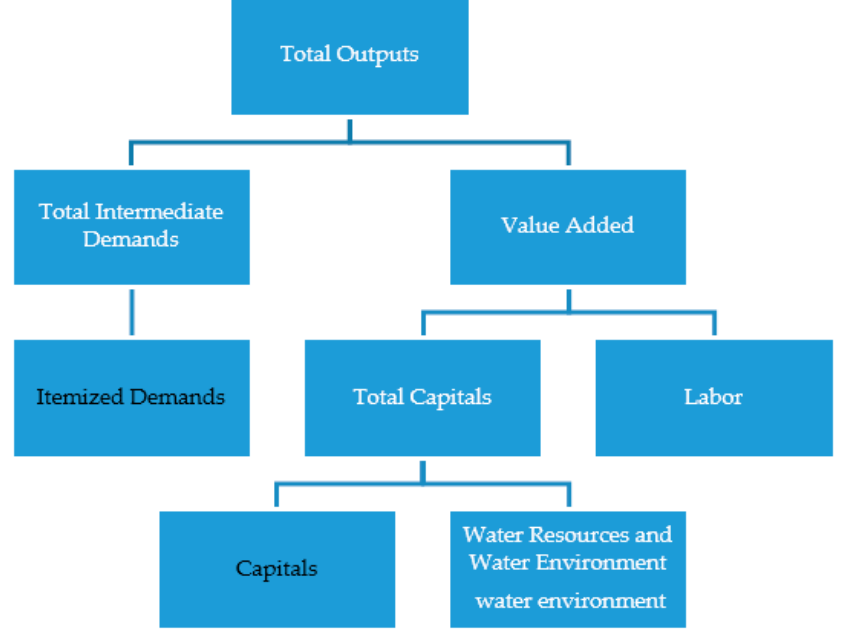
Figure 1. Nested relationships of production.